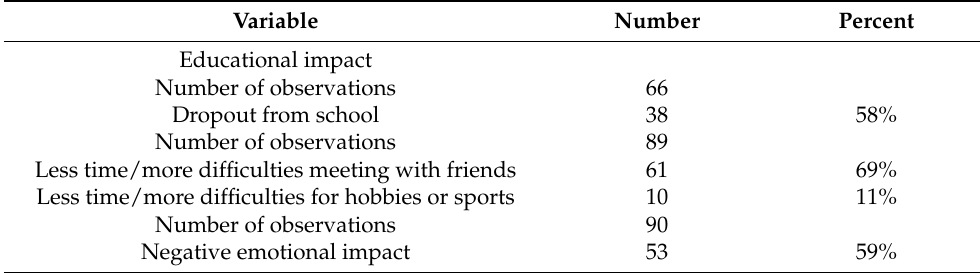
Table 3. Educational, social, and emotional impacts on the